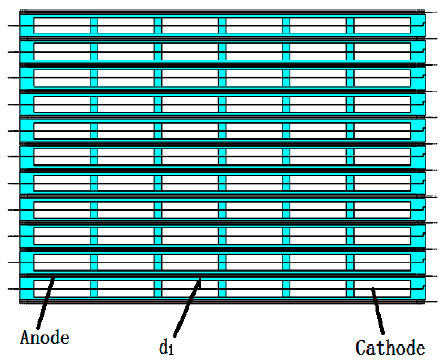
Figure 2. Basic structure of partially parallel single cells. Table 1. Size parameters of the initial model.